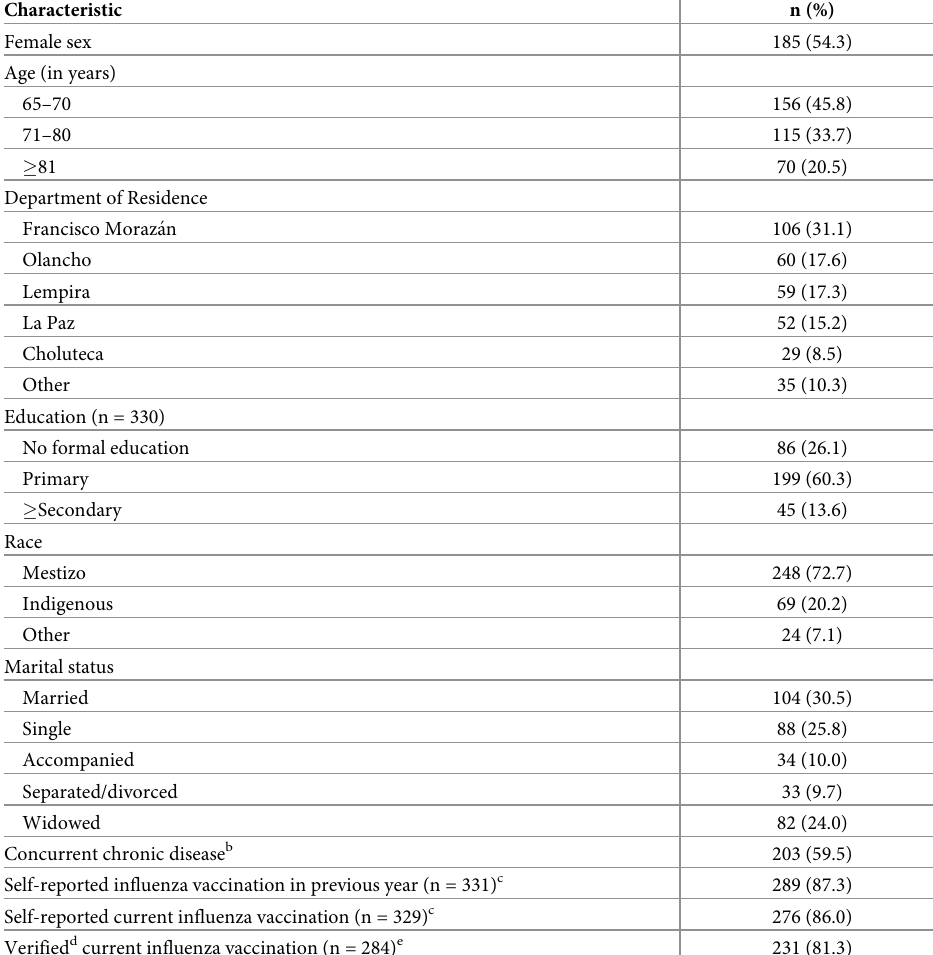
Table 1. Demographics of 341 older adults in nursing homes and daycare centers a , Honduras, August 29 to Octo- ber 26, 2018.